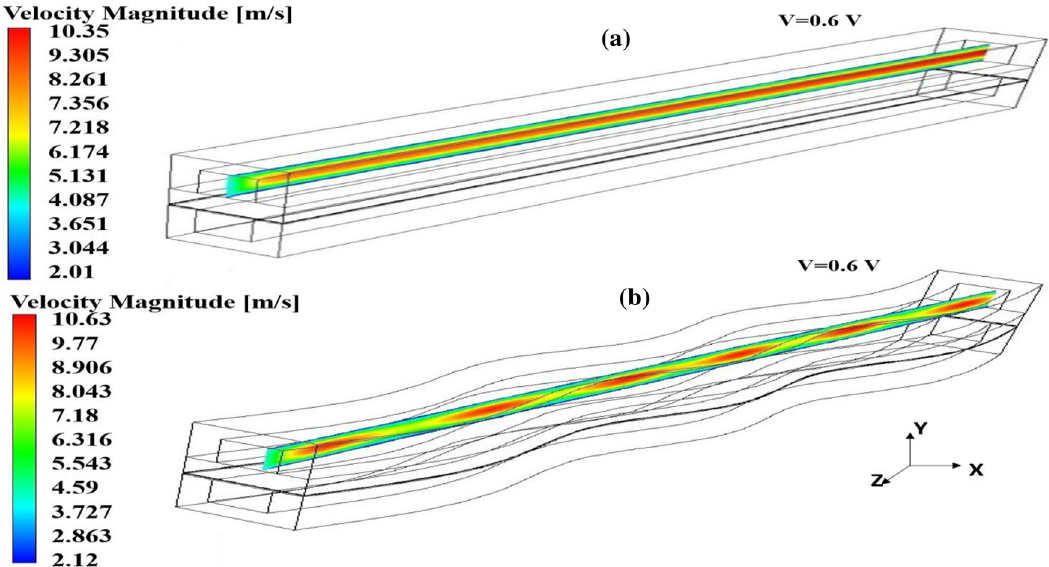
Fig. 3. Velocity distribution contour along the anode channel for two different fl ow designs at 0.6